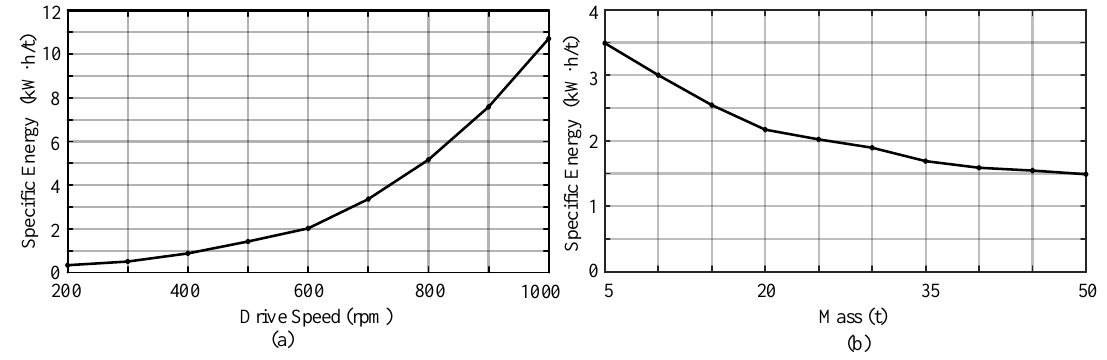
Figure 24. The e ff ect of drive speed and fixed cone mass on specific energy consumption simulation results as: ( a ) specific energy consumption for di ff erent speeds in the 24 t case; ( b ) specific energy consumption for di ff erent masses in the 600 rpm case.